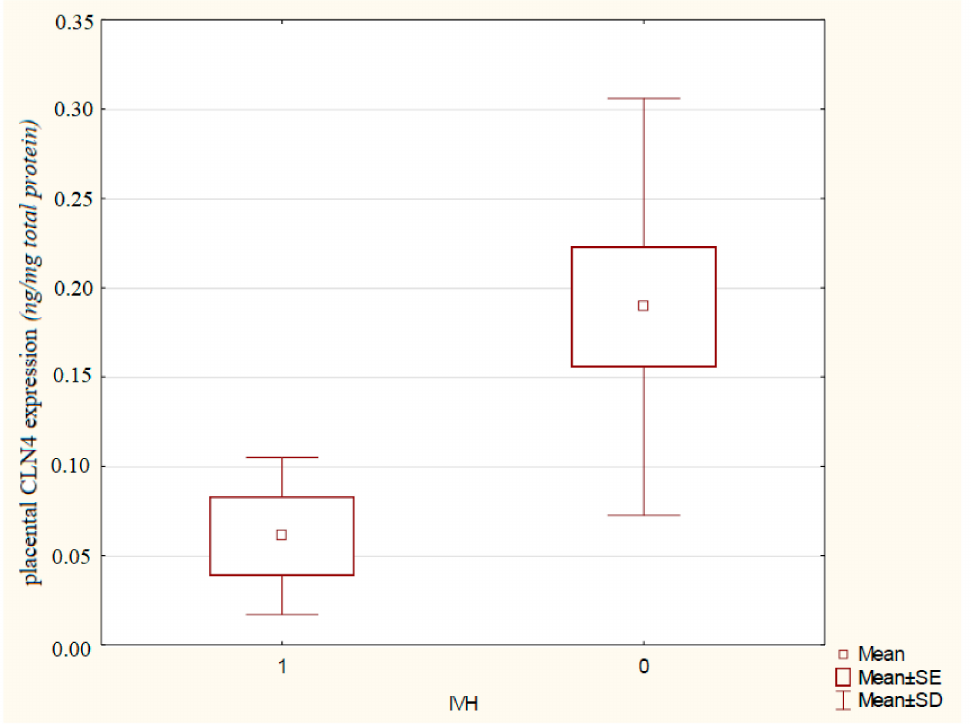
Figure 1. Comparison of the placental CLN4 expression in pregnancy complicated by fetal growth re- striction with brain-sparing regarding the occurrence of an intraventricular hemorrhage in